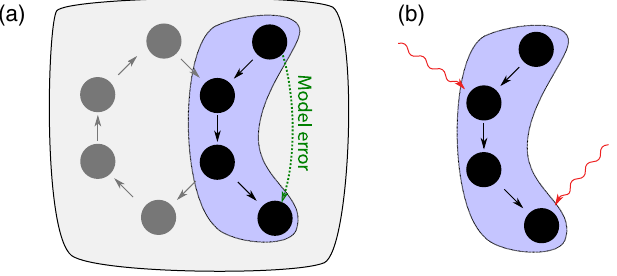
FIG. 1. Schematic illustration of an open system and its environment. (a) The open system (blue shadowed region) interacts with its dynamic environment. The state (black nodes) of the open system is determined by both internal interactions and by the interactions with the (unknown) state of the environment (gray nodes). There are also systematic model errors, as indicated by a missing interaction between state variables (green dashed line). (b) Both the effects of the environment on the state of the open system and model errors can be regarded as unknown